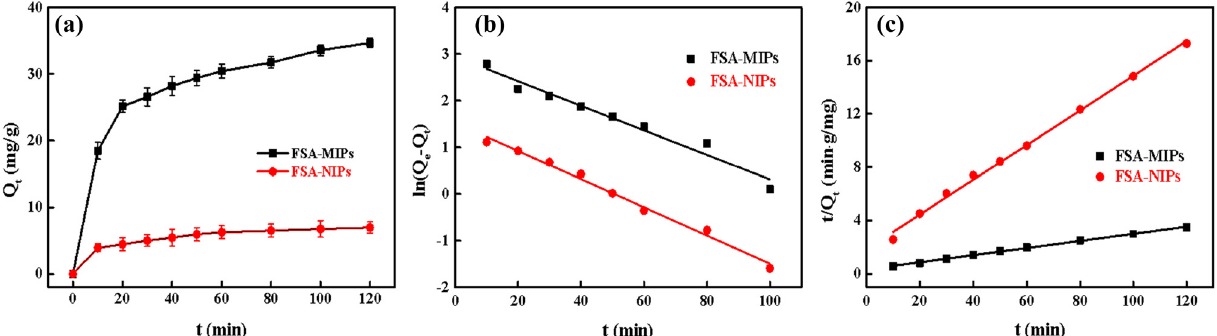
Figure 4: ( a ) Adsorption kinetics, ( b ) pseudo - fi rst - order model, and ( c ) pseudo - second - order model of 4 - MMC onto FSA - MIPs and FSA - NIPs at 308